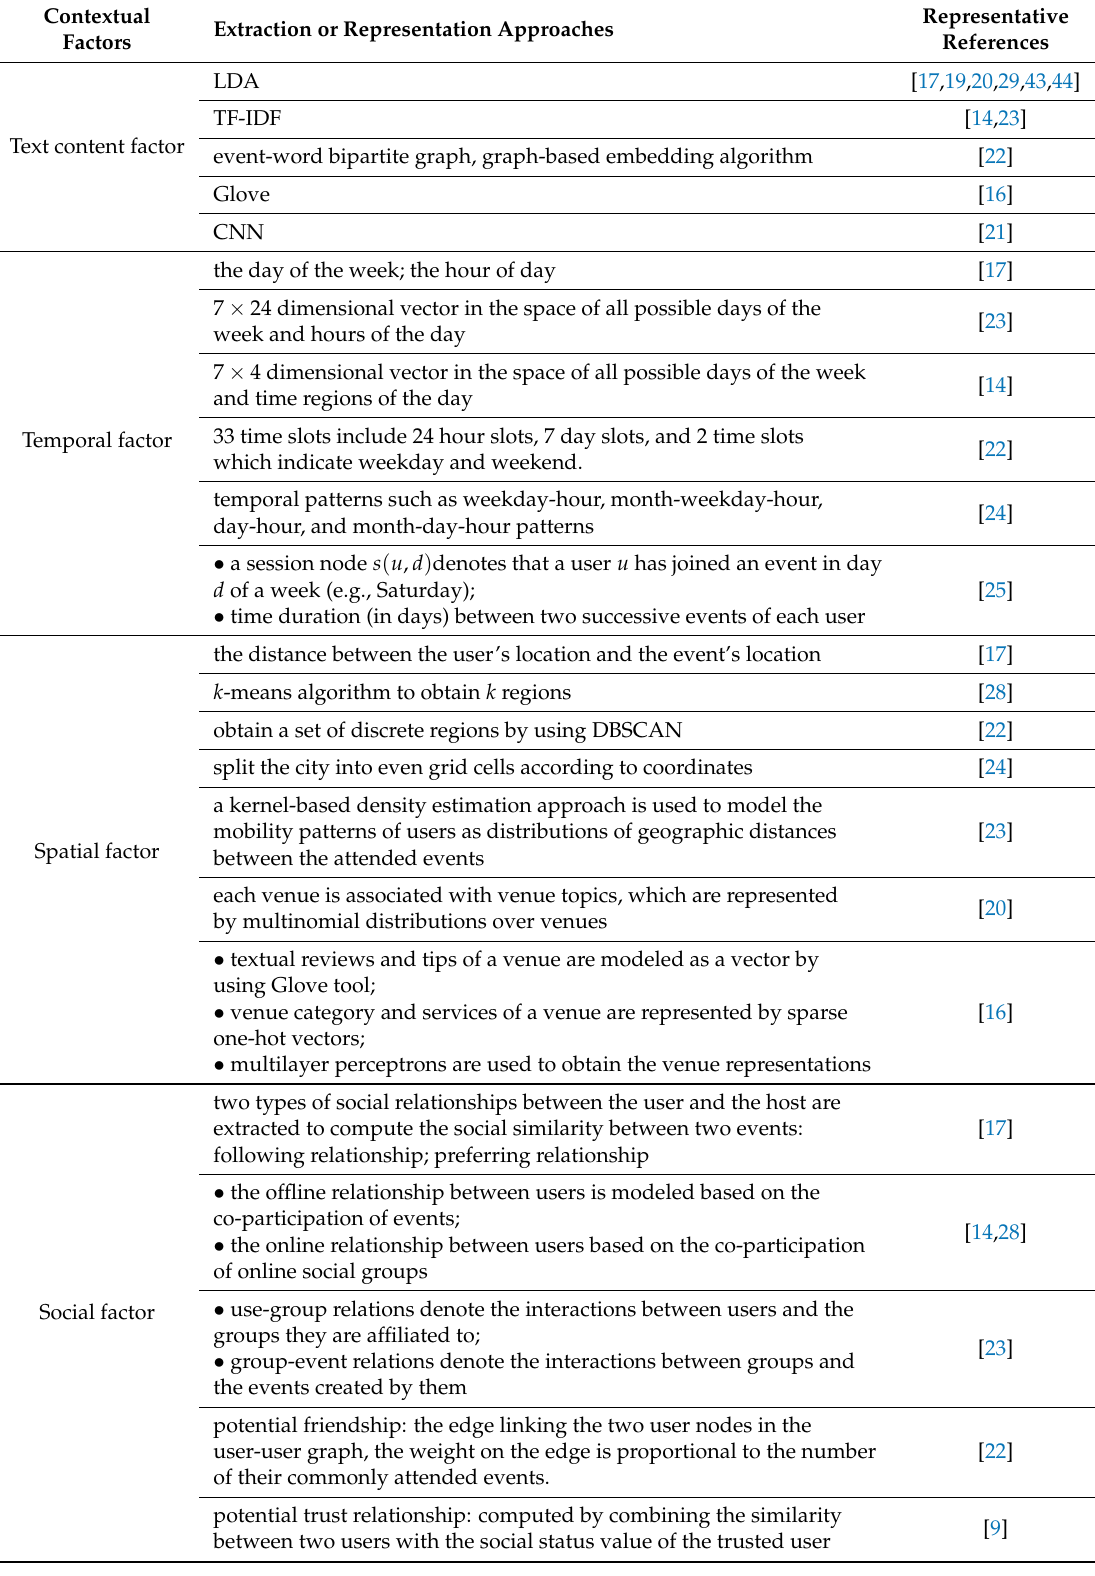
Table 1. Summary of contextual factors used in Context-Aware Recommender Systems